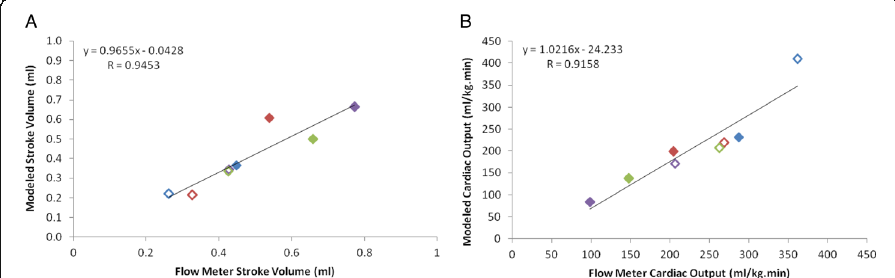
Fig. 4 Comparison of flow meter and tracer kinetically modeled a stroke volume and b cardiac output at baseline and postxylazine infusion at 13.8 mg/kg min [19]. The equation in each chart represents the linear relationship between the measures, while the measure of fit is provided by the Pearson product-moment correlation coefficient ( R ). In all cases, unique colors represent individual animals at baseline ( open symbols ) and post xylazine ( filled symbols ) treatment